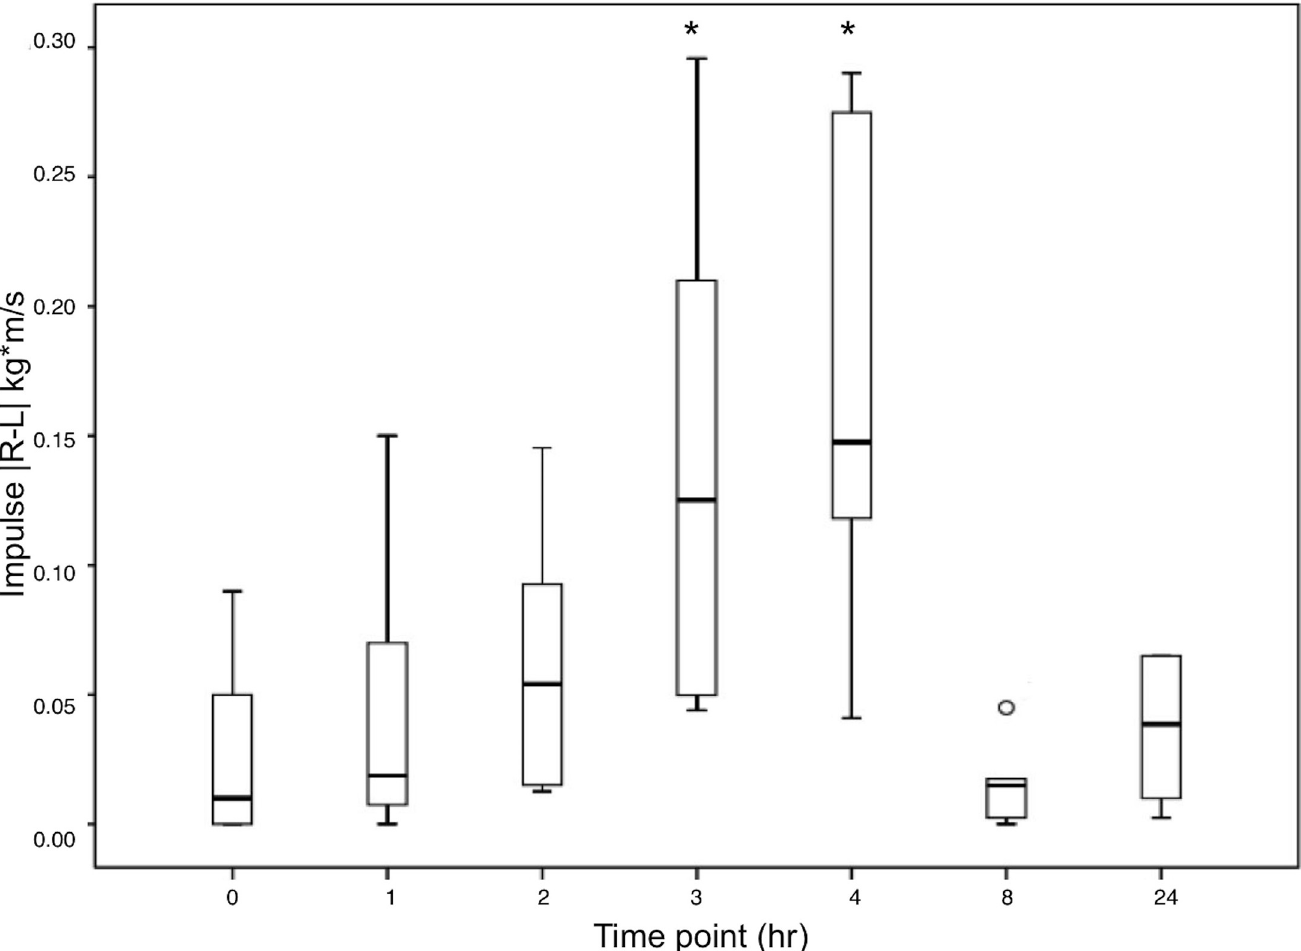
Fig 4. Impulse. Boxplot depicting the absolute value of the difference between impulse (kg � m/sec) of right and left feet of Muscovy ducks ( Cairina moschata domestica ) as measured by a pressure sensitive walkway at serial time points following induction of lameness with intratarsal injection of monosodium urate solution. Asterisks represent a significant increase at hours 3 and 4.